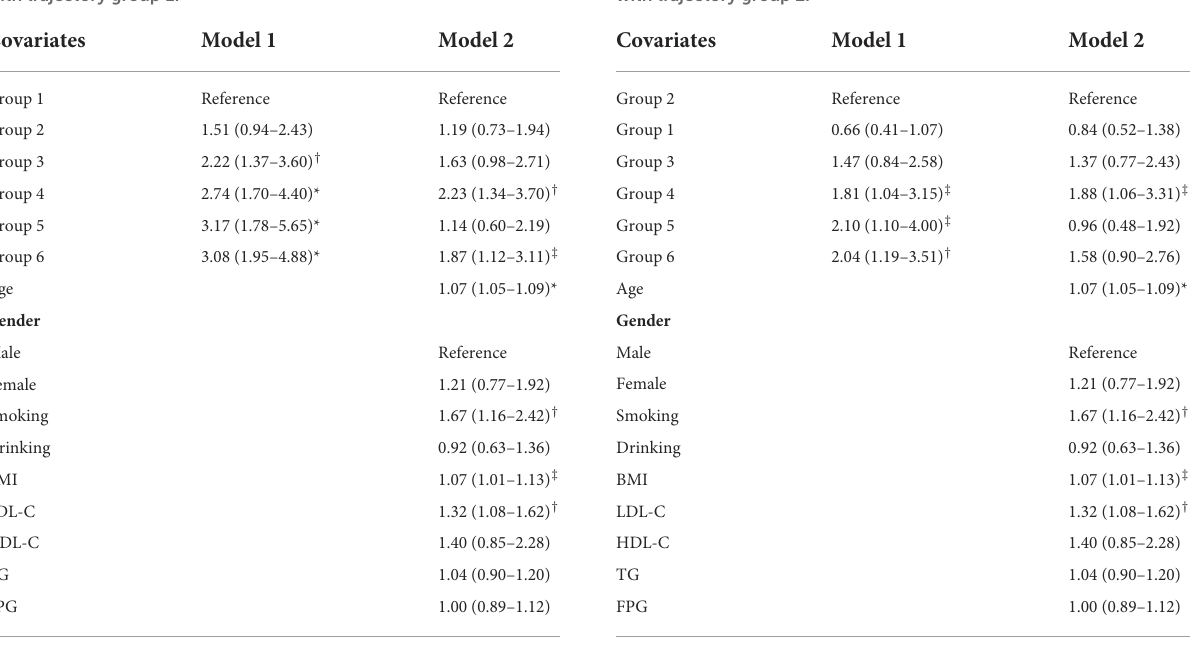
TABLE 2 ORs and 95% CIs of multi-trajectories on CHD risk compared with trajectory group 1.